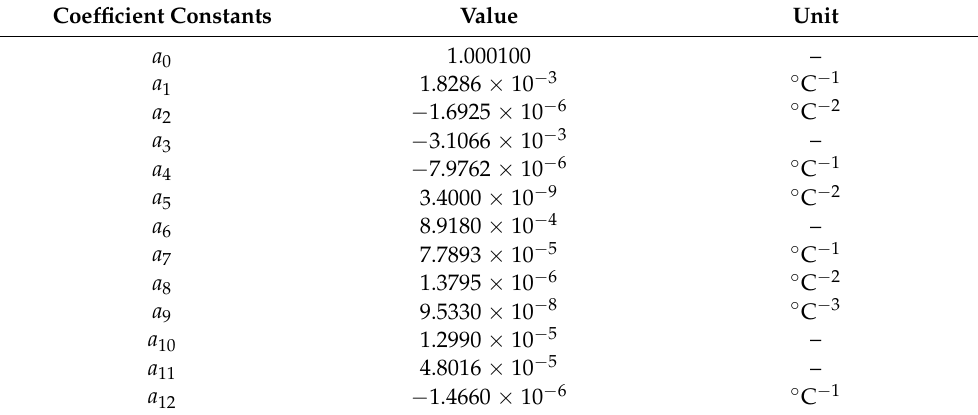
Table 1. Coefficients for the computation of c / c 0